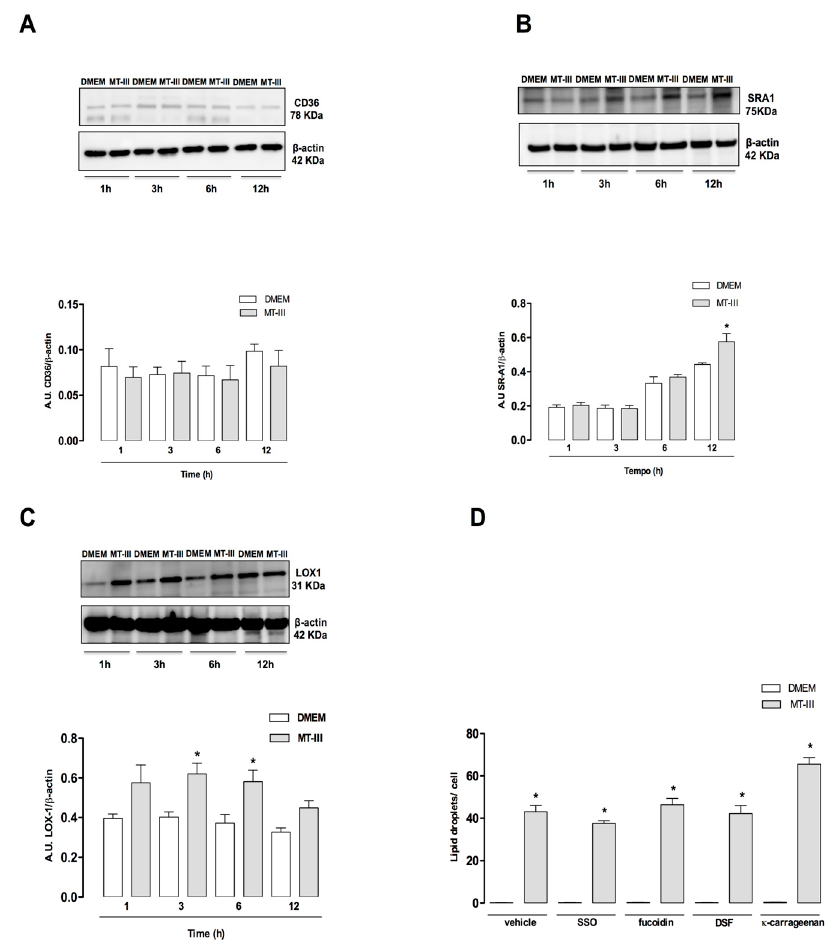
Figure 7. E ff ect of MT-III on protein expression of SR-A1, LOX-1, and CD36 by VSMCs and the e ff ect of scavenger receptor inhibitors on LD formation induced by MT-III. VSMCs (5 × 10 4 cells / well) were incubated with MT-III (0.4 µ M) or DMEM (control) for 1, 3, 6, and 12 h. Western blotting and densitometric analysis ofCD36 ( A ), SR-A1 ( B ), LOX-1 ( C ), and β -actin (loading control) in VSMC extracts. The densities were normalized with those of β -actin. ( D ) Treatment of VSMCs (8 × 10 3 cells / coverslip) with SSO (250 µ M) or fucoidin, dextran sulphate sodium salt (250 µ M), or kappa-carrageenan (250 µ M) for 1h before stimulation with MT-III (0.4 µ M) for 12h. LDs were counted using light microscopy after osmium staining. The results are expressed as the mean ± SEM from three independent experiments ( n = 9) (ANOVA). Note: * p < 0.05 compared with control